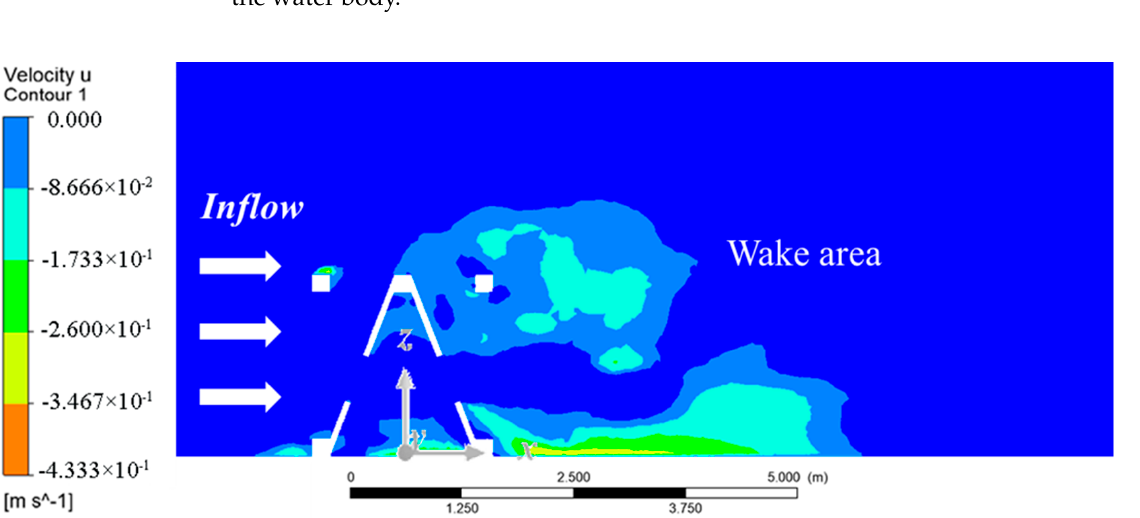
Figure 6. Wake region of the x - z plane ( y = 0).